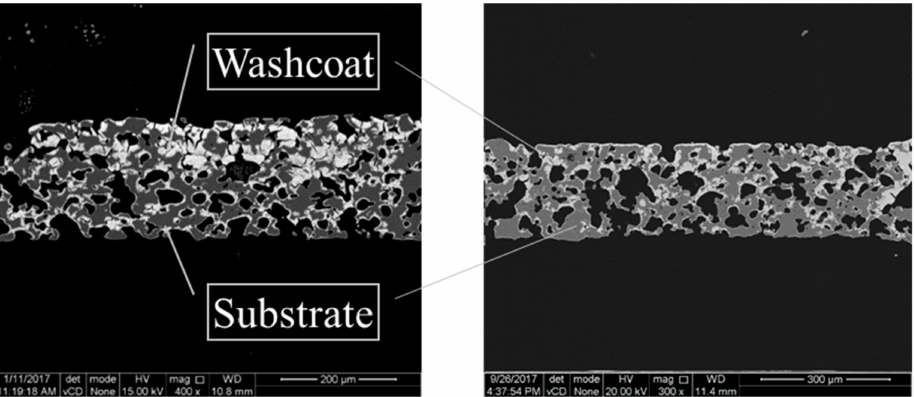
Figure 4. SEM images of the GPF samples of GPF-A and GPF-B.